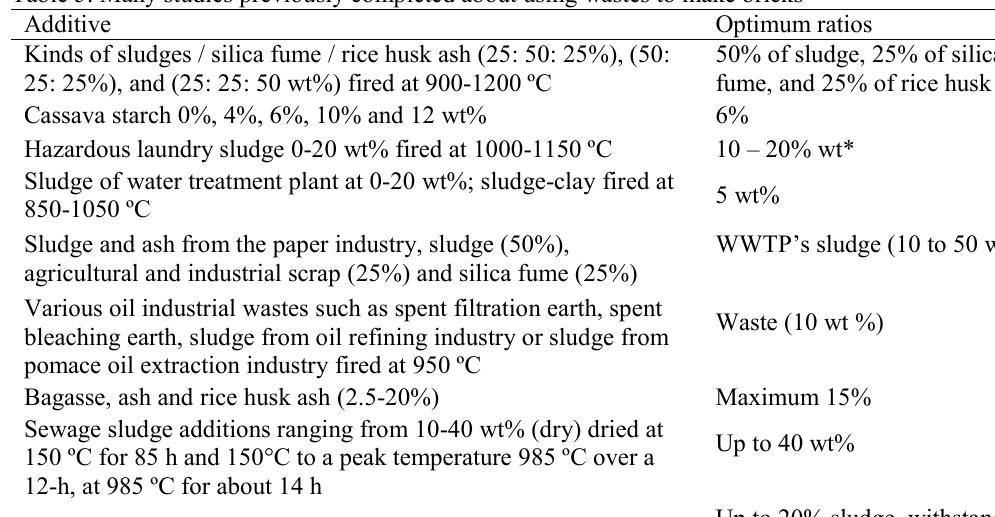
Table 5. Many studies previously completed about using wastes to make bricks Additive Optimum ratios Ref.